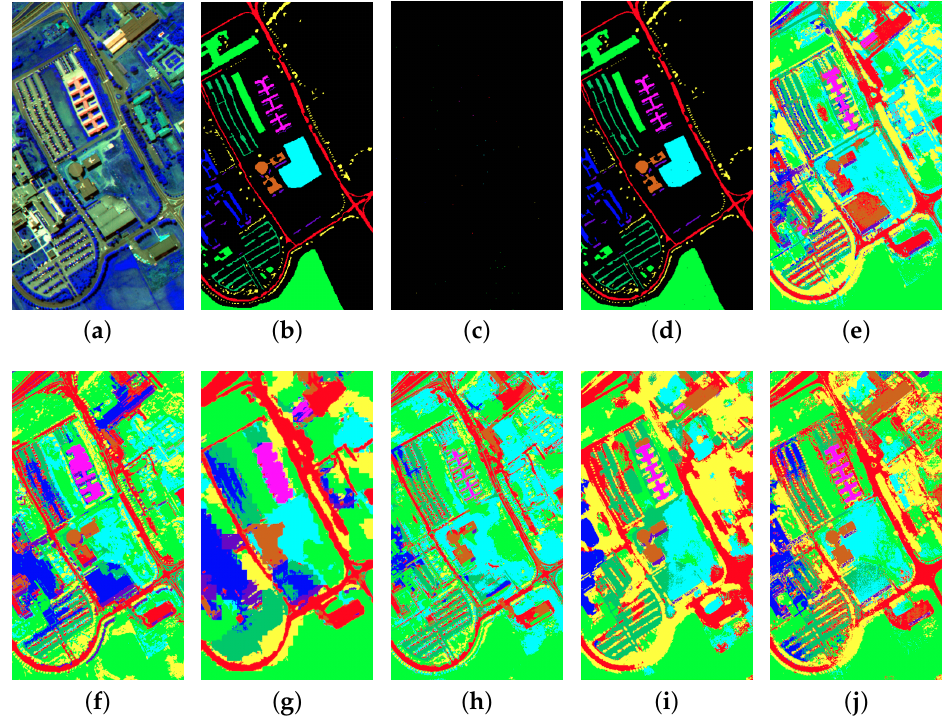
Figure 7. Classification maps of different methods on the Pavia University data set. ( a ) False Colour Image; ( b ) Ground Truth; ( c ) Training set; ( d ) Test set; ( e ) LCMR; ( f ) SCMK; ( g ) CEGCN; ( h ) PRNet; ( i ) LCEM; ( j )